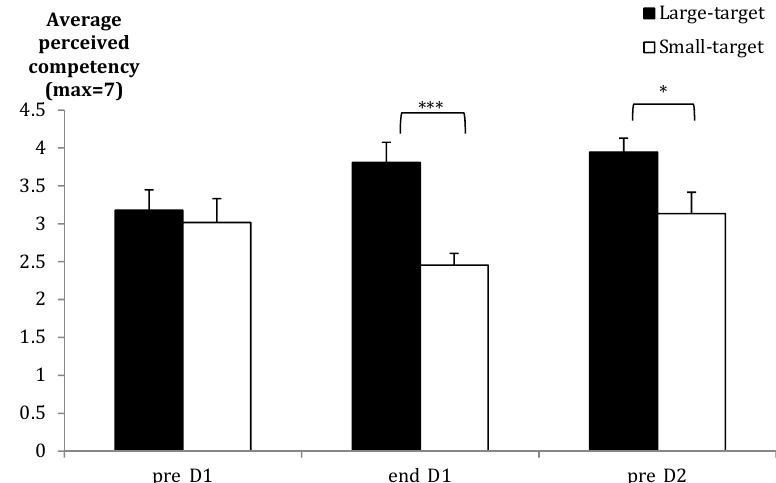
Figure 2. Mean group ratings (SE bars) for perceived competency before Acquisition Day 1 (pre_D1), after Acquisition Day 1 (end_D1), and before retention tests on Day 2 (pre_D2). * p < 0.05; *** p < 0.001. Brain Sci. 2019 , 9 FOR PEER REVIEW